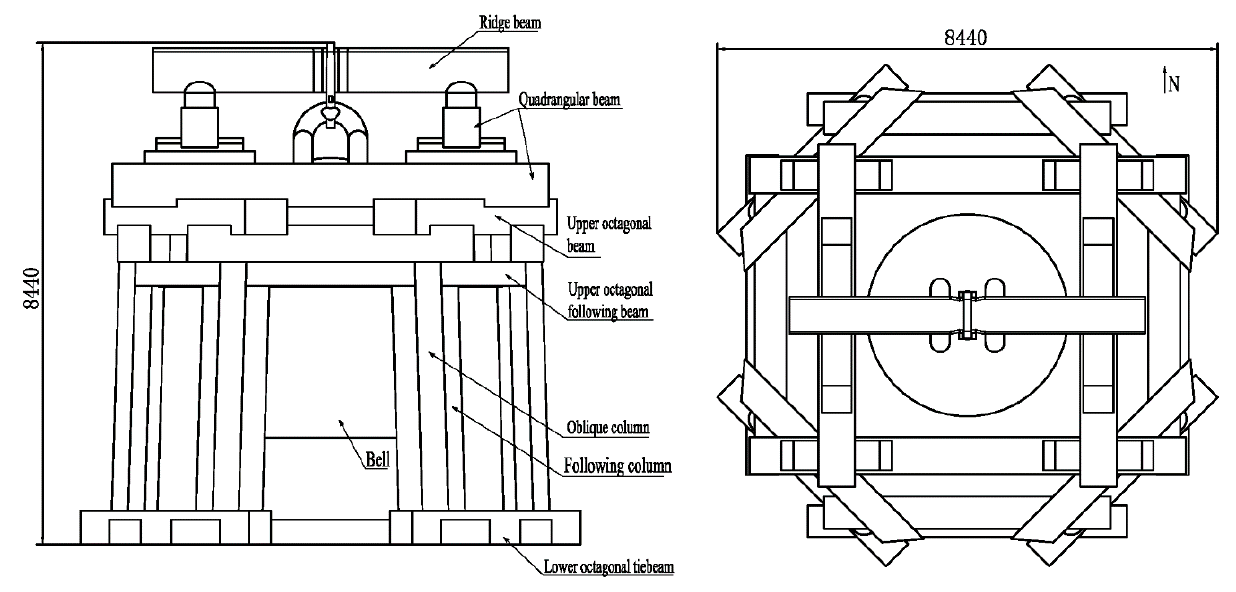
Figure 5. Projection of the octagonal wooden frame [52].